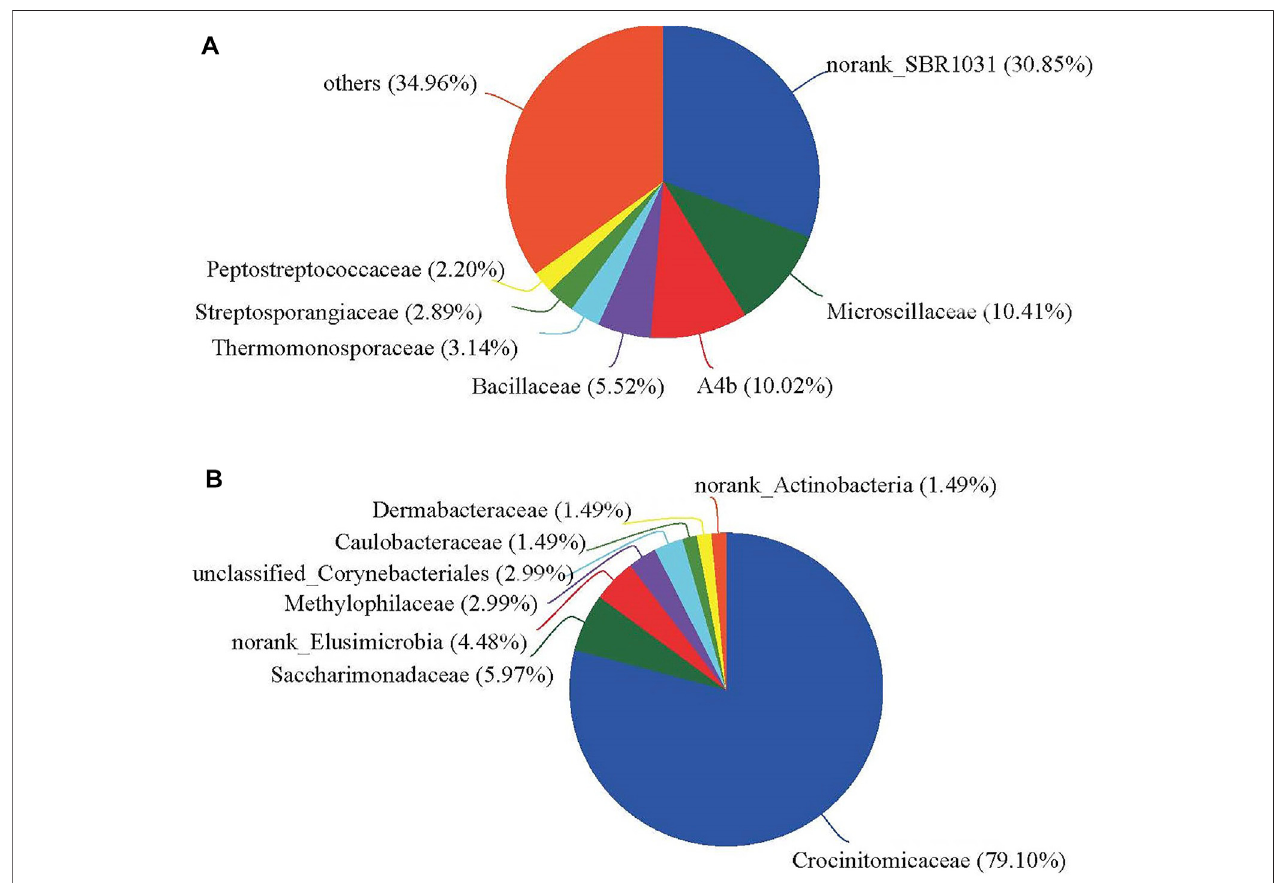
FIGURE 4 | Pie charts conveying the unique and common families in the bacterial community in swine manure composting: (A) main families common to all six antibiotic treatments (T0 to T5), and (B) those families uniquely found in response to the cipro fl oxacin addition treatment (i.e., T4).